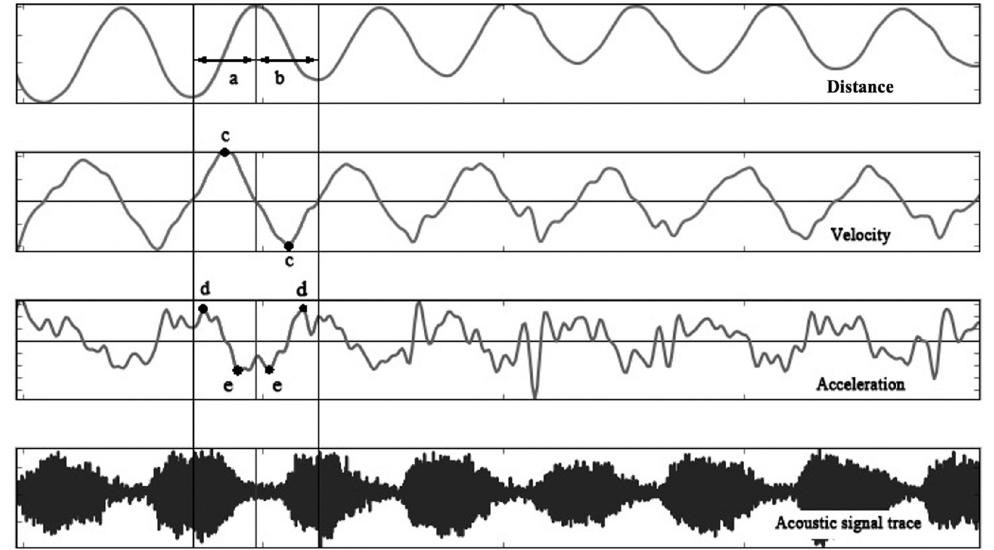
Fig 3. An illustration of kinematic analysis of DDK production using a custom-written EMA analysis programme, Articuno. Note: Example displacement, velocity, acceleration and acoustic signal profiles displaying (a) approach phase, (b) release phase, (c) points of maximum velocity, (d) points of maximum acceleration, and (e) points of maximum